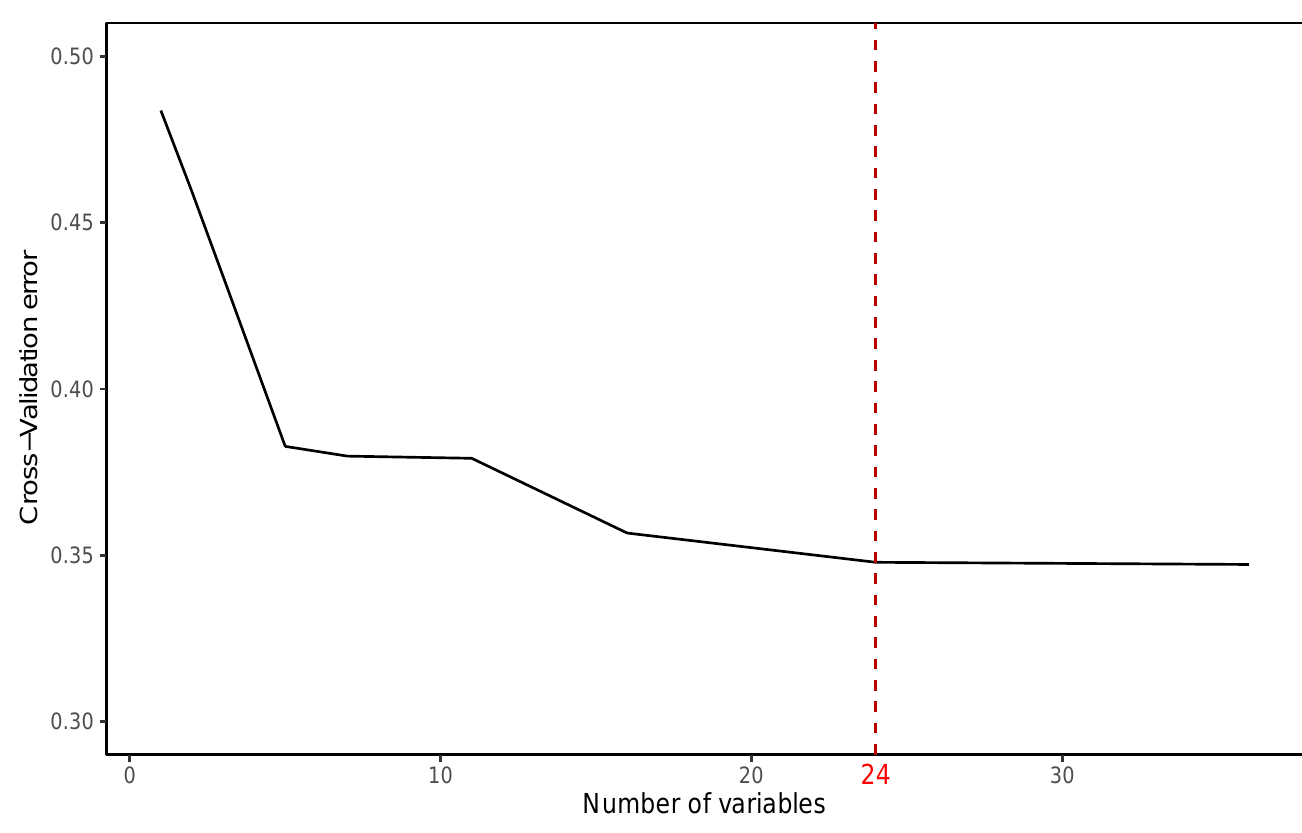
Figure 3. Determining the optimal variable set for the soundscape comfortable model based on CV